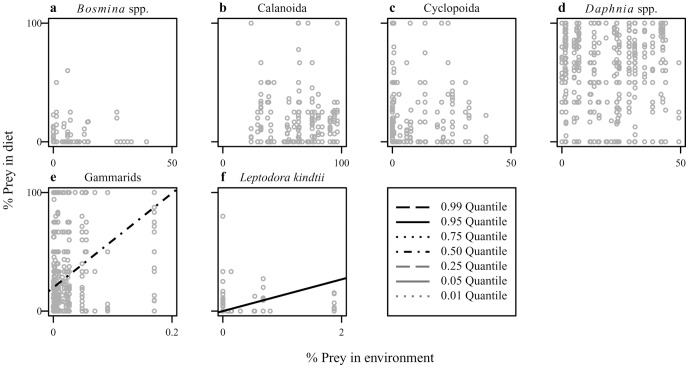
Scatter plot showing the relationships between numerical composition of prey in the diet and environment.(a) Bosmina spp., (b) Calanoida, (c) Cyclopoida, (d) Daphnia spp., (e) gammarids, and (f) Leptodora kindtii. Only significant (p<0.05) quantile regressions are shown.